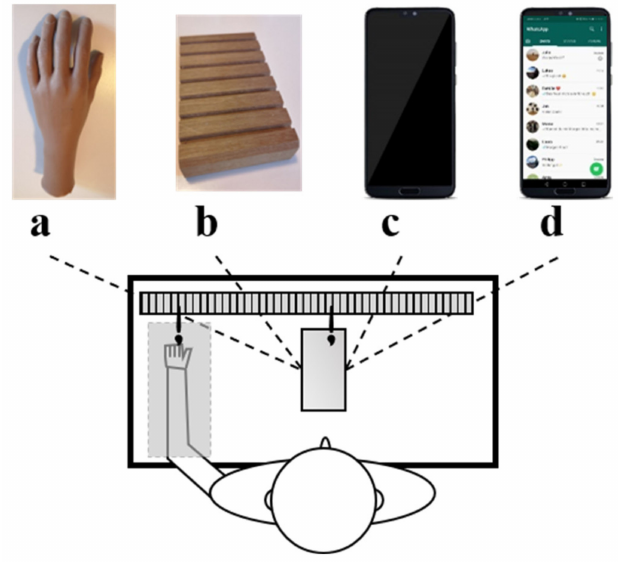
Figure 1. Set-up and test objects: ( a ) rubber hand, ( b ) neutral control object wooden block, ( c ) smartphone neutral and ( d ) smartphone plus activated